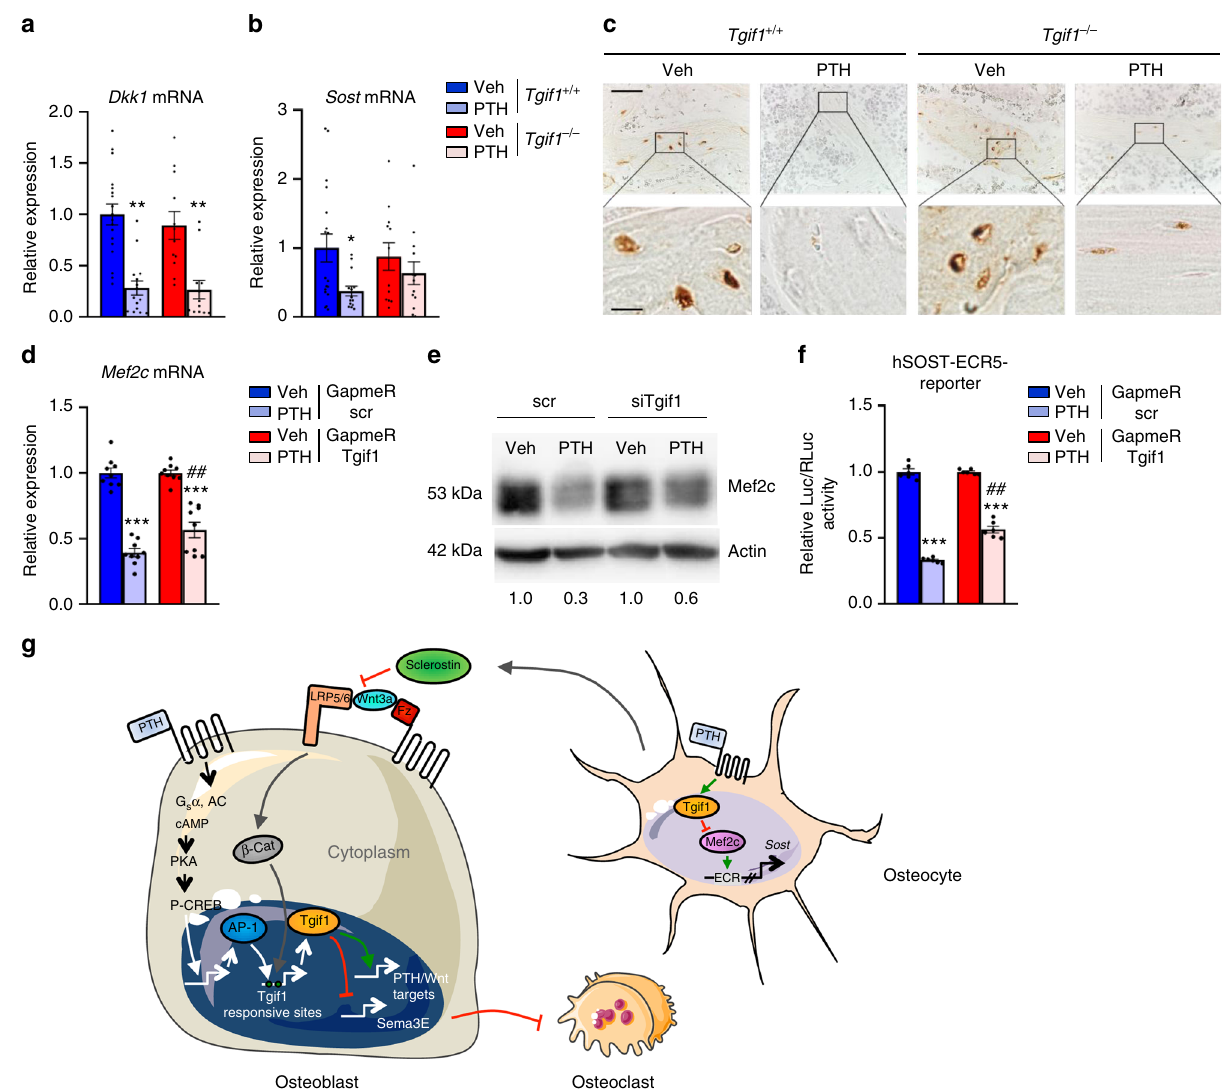
Fig. 7 Suppression of sclerostin expression by parathyroid hormone (PTH) depends in part on TG-interacting factor 1 (Tgif1). a Relative expression of Dkk1 mRNA and of b Sost mRNA in tibiae of Tgif1 + / + and Tgif1 − / − mice 4 h after injection of PTH or vehicle (Veh) ( Tgif1 + / + + Veh: N = 18, Tgif1 + / + + PTH: N = 14, Tgif1 − / − + Veh: N = 12, Tgif1 − / − + PTH: N = 13). c Immunohistochemical staining of sclerostin expression in tibiae of Tgif1 + / + and Tgif1 − / − mice after treatment with PTH or Veh. Scale bars indicate 50 μ m (lower magni fi cation, upper panel) and 10 μ m (higher magni fi cation, lower panel). d Relative expression of Mef2c mRNA in UMR-106 cells. Cells were transfected with scrambled (scr) control GapmeR or GapmeR targeting Tgif1. After 48 h, cells were stimulated with PTH or Veh for 8 h ( N = 3). e Immunoblot demonstrating the protein abundance of Mef2c in UMR-106 cells. Cells were transfected with scr siRNA or siRNA targeting Tgif1 (siTgif1). After 48 h, cells were stimulated with PTH or Veh for 8 h. Immunoblot for Actin was used as a loading control. Normalized fold expression and molecular weight in kilo Dalton (kDa) are indicated (representative image of 3 experiments). f UMR-106 cells were transfected with scr GapmeR or GapmeR targeting Tgif1 and 24 h later with a hSOST-ECR5 reporter construct. After 8 h, cells were stimulated with PTH or Veh for 16 h. Shown is the relative luciferase activity (GapmeR scr + Veh: N = 3, GapmeR scr + PTH: N = 3, GapmeR Tgif1 + Veh: N = 3, GapmeR Tgif1 + PTH: bars represent the s.e.m. Statistical analysis was performed using analysis of variance (ANOVA) followed by Newman – Keuls post-hoc test. g Schematic drawing of the function of Tgif1 in osteoblasts, osteocytes and in response to the activation of the canonical Wnt and PTH bone anabolic